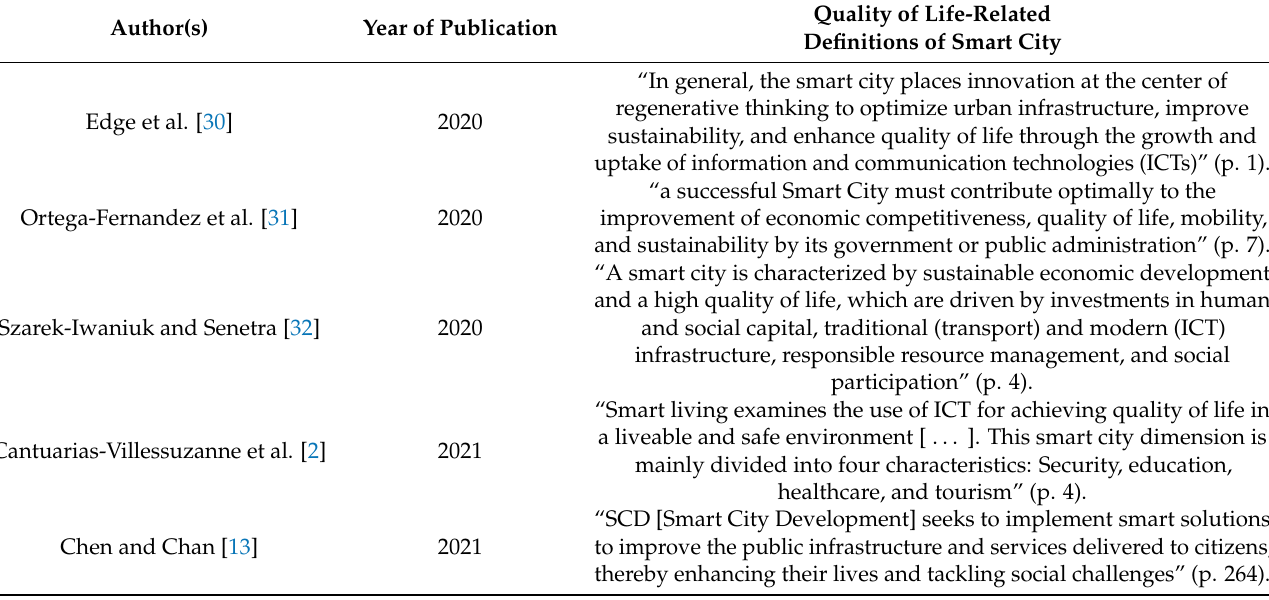
Table 2. Quality of life-related definitions of smart cities. Source: Authors’ own